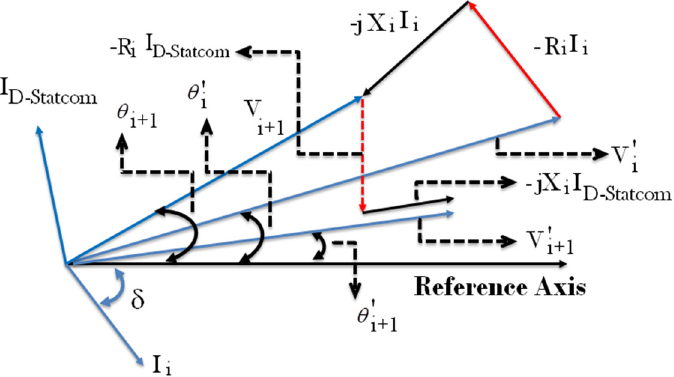
Figure 14. HFC D-STATCOM Phasor technique structure installation in feeder 𝑖 + 1 .